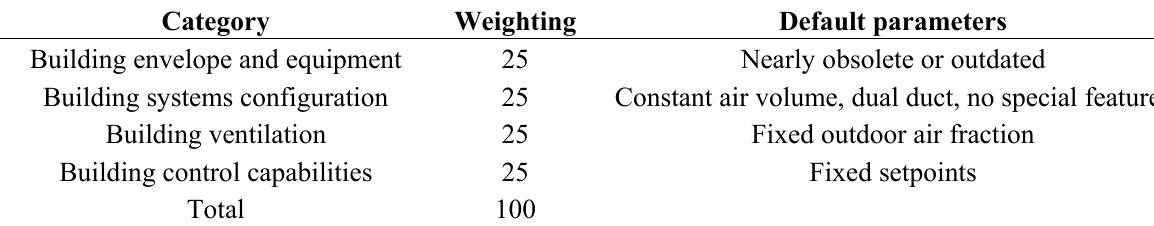
Table 4. BDI category weightings and default parameters.